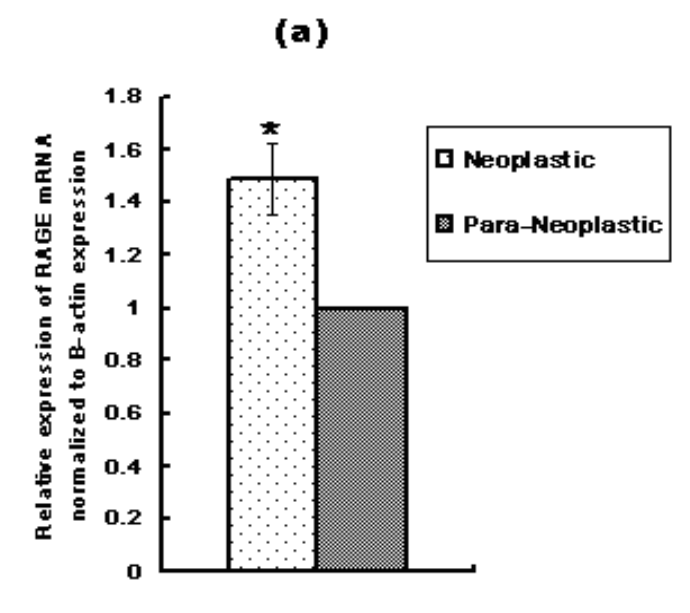
Figure 1. Expression of RAGE mRNA and protein in Primary Cellular Carcinoma (PHC) and their matched-adjacent liver tissues by qRT-PCR and Western Blot. ( a ) Relative expression of RAGE mRNA normalized to β-actin expression (neoplastic vs. para-neoplastic) analyzed by qRT-PCR (average ΔCt of ten samples); ( b ) Expression of RAGE protein by Western Blot; ( c ) Expression of RAGE protein as a ratio to β-actin. The pictures represent the results for 5 patients out of the total 10 patients. In all the patients RAGE mRNA and protein expression in PHC tissues was significantly higher than their matched-adjacent tissues ( * p < 0.01, # p < 0.01). Lanes 2, 4, 6, 8, 10: RAGE expression in PHC. Lanes 1, 3, 5, 7, 9: RAGE expression in matched-adjacent liver tissues. M: molecular weight marker. Three independent measurements were made and